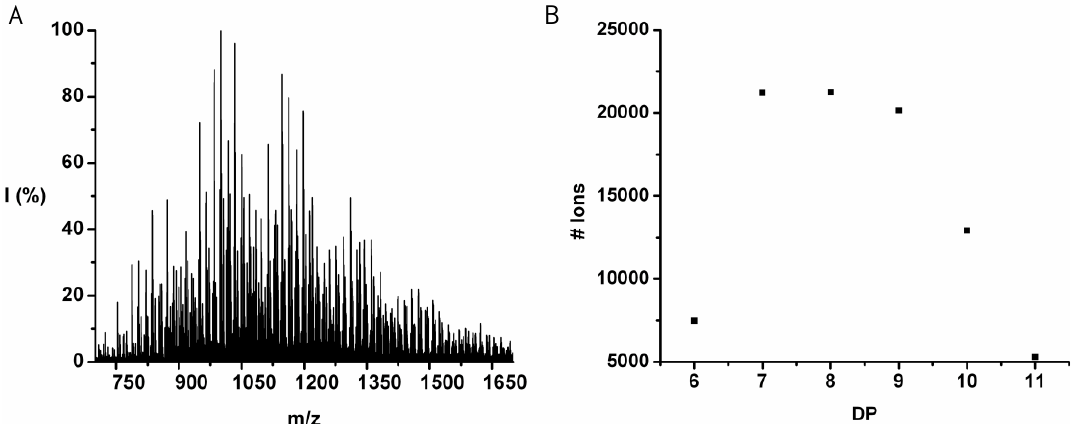
Figure 22. ( A ) MALDI-ToF mass spectrum and ( B ) chain length distribution of Oligo(Phe-co-Tyr-co-Leu).